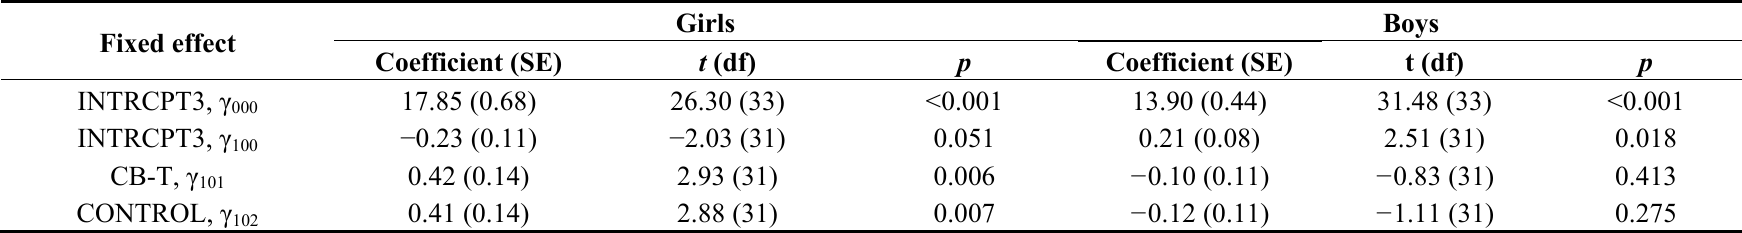
Table 2. Fixed effects examining differences by condition in monthly change in depression from post-intervention to 12 month follow-up. Fixed